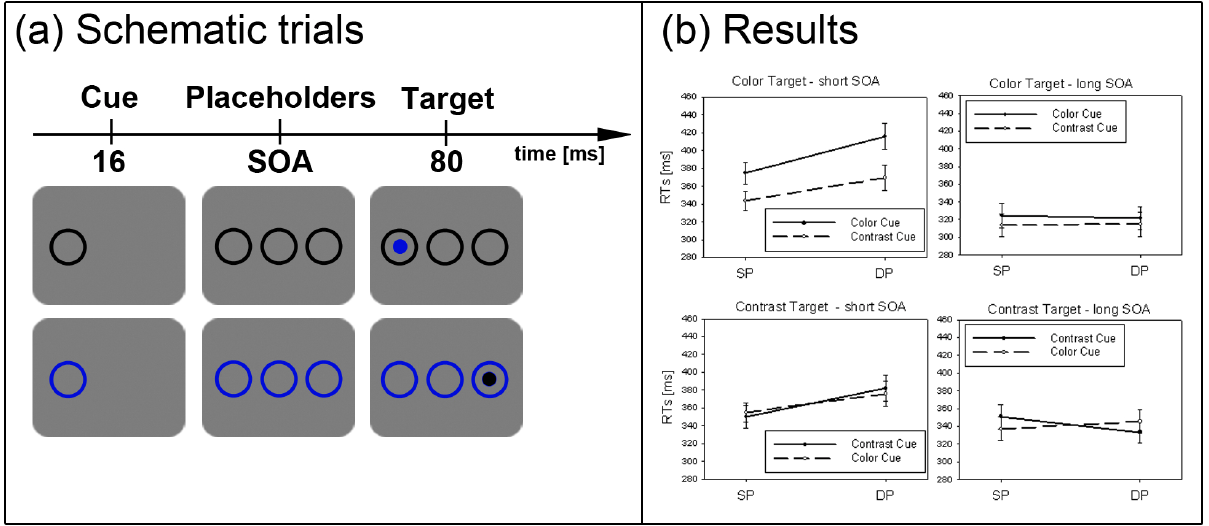
Figure 2. Experiment 1. ( a ) Depicted are schematic examples of trials. The top row shows a contrast cue and a blue target (same position (SP) condition). The bottom row depicts a color cue and a black target (different position (DP) condition). ( b ) Depicted are mean reaction times (RTs) and standard errors of the mean (error bars) of all participants, plotted separately for the short (left side) and long Stimulus Onset Asynchrony (SOA) (right side) and for color targets (top row) and contrast targets (bottom row). Results are shown for SP (left side of each panel) and DP conditions (right side of each panel). Results are plotted separately in each panel for cues of the same contrast or color (solid line) and different contrast or color cues (dashed